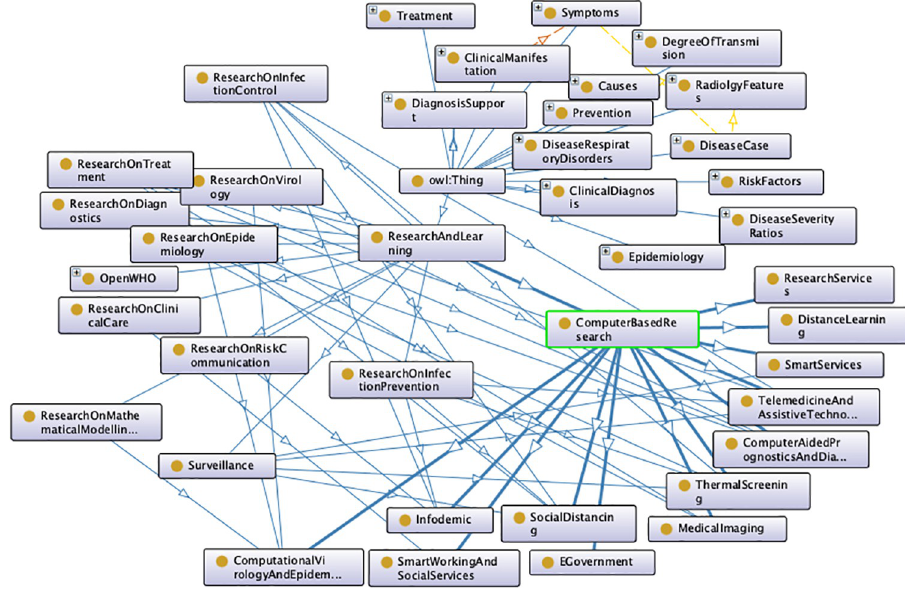
Fig 33. Taxonomy.